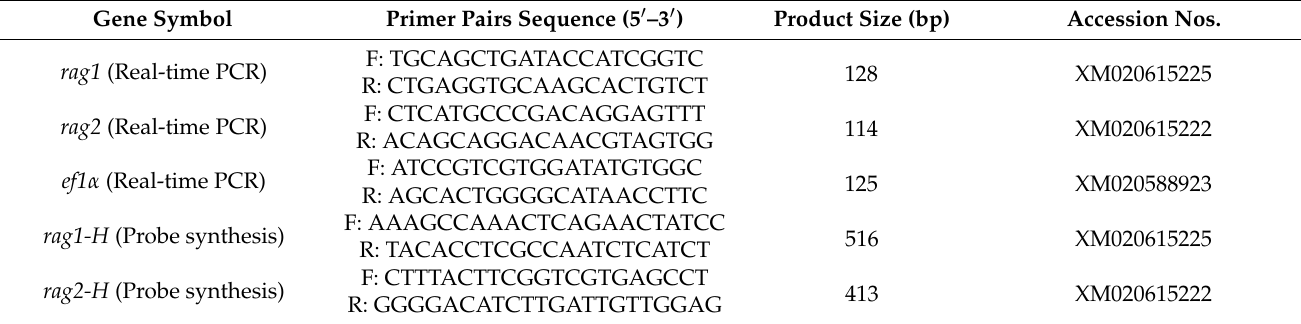
Table 1. Primers used in this